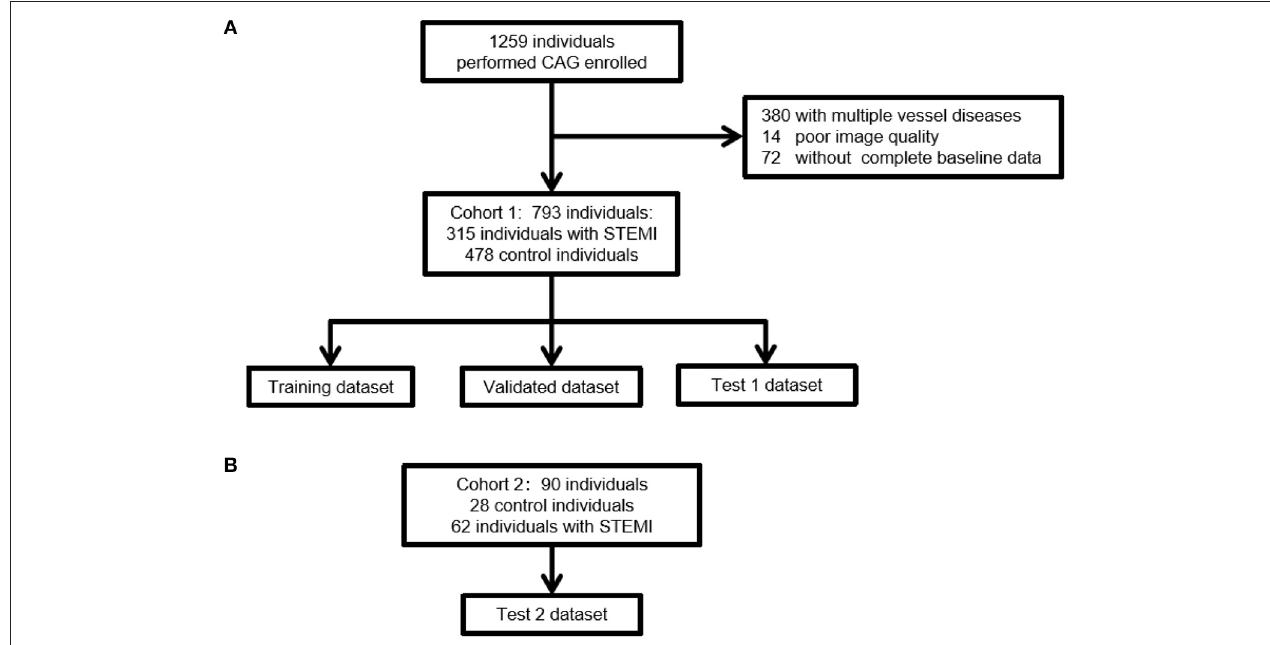
FIGURE 1 | A flow diagram indicating the selection of individuals for the training, validation, and testing datasets. (A) The selection steps of Cohort 1 for the internal dataset. Of the 793 ECGs collected, Cohort 1 included 315 individuals with STEMI and 478 control individuals without STEMI. (B) The selection steps of external validation of ECG. Of the 90 ECGs collected, Cohort 2 included 62 individuals with STEMI and 28 control individuals without STEMI. The inclusion and exclusion criteria were consistent with those in Cohort 1. STEMI, ST segment elevation myocardial